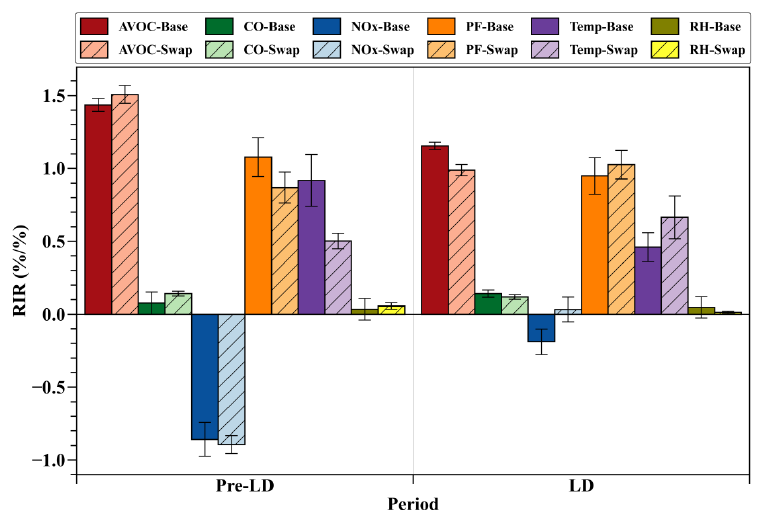
Figure 6. Average RIR values of anthropogenic VOCs (AVOC), CO, NO x , photolysis frequencies (PF), temperature (Temp), and relative humidity (RH) determined in the base runs (Base) and swap runs (Swap) in two periods. Error bars represent the 95% confidence intervals.